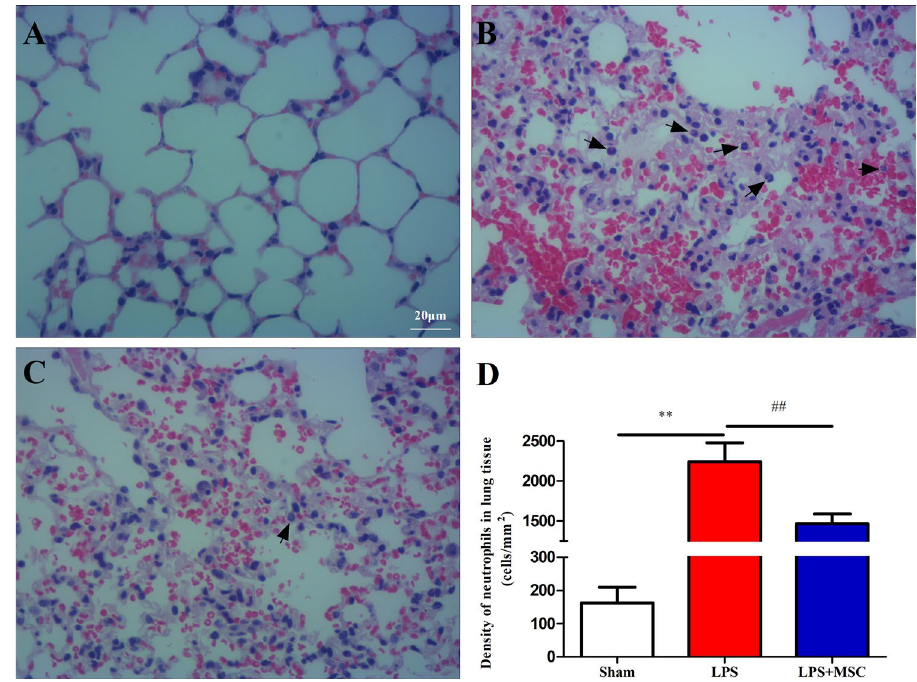
Figure 4. Neutrophil density in the lung tissue 6 h after LPS treatment. The microphotograph shows the density of neutrophils in the lung tissue. ( A ) Sham group, ( B ) LPS group, ( C ) LPS + MSC group, ( D ) the density of neutrophils in lung tissue. * P < 0.05 versus the Sham group; # P < 0.05 versus the LPS group; ** P < 0.01 versus the Sham group; ## P < 0.01 versus the LPS group. Values are expressed as the mean ± SD. Values are expressed as the mean ± SD. ( A – C , ×100 magnification).